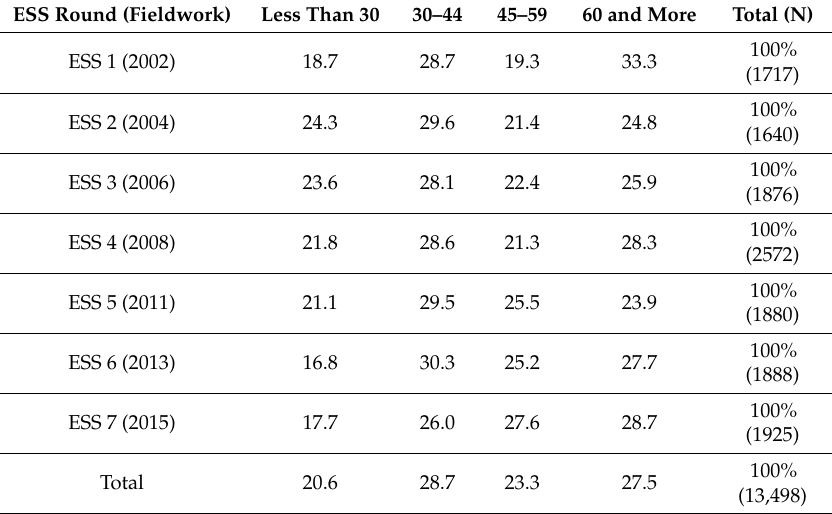
Table A2. Distribution of cases among age groups and year of data